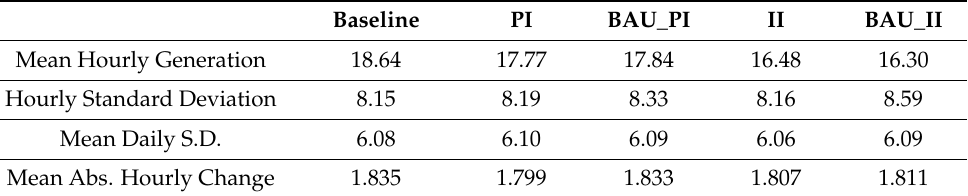
Table 6. Description of the electricity prices (£/MWh) of each scenario, showing that island renew- able capacity would not reduce average prices as much as offshore wind, but would have a stabi- lizing effect on the volatility of prices.